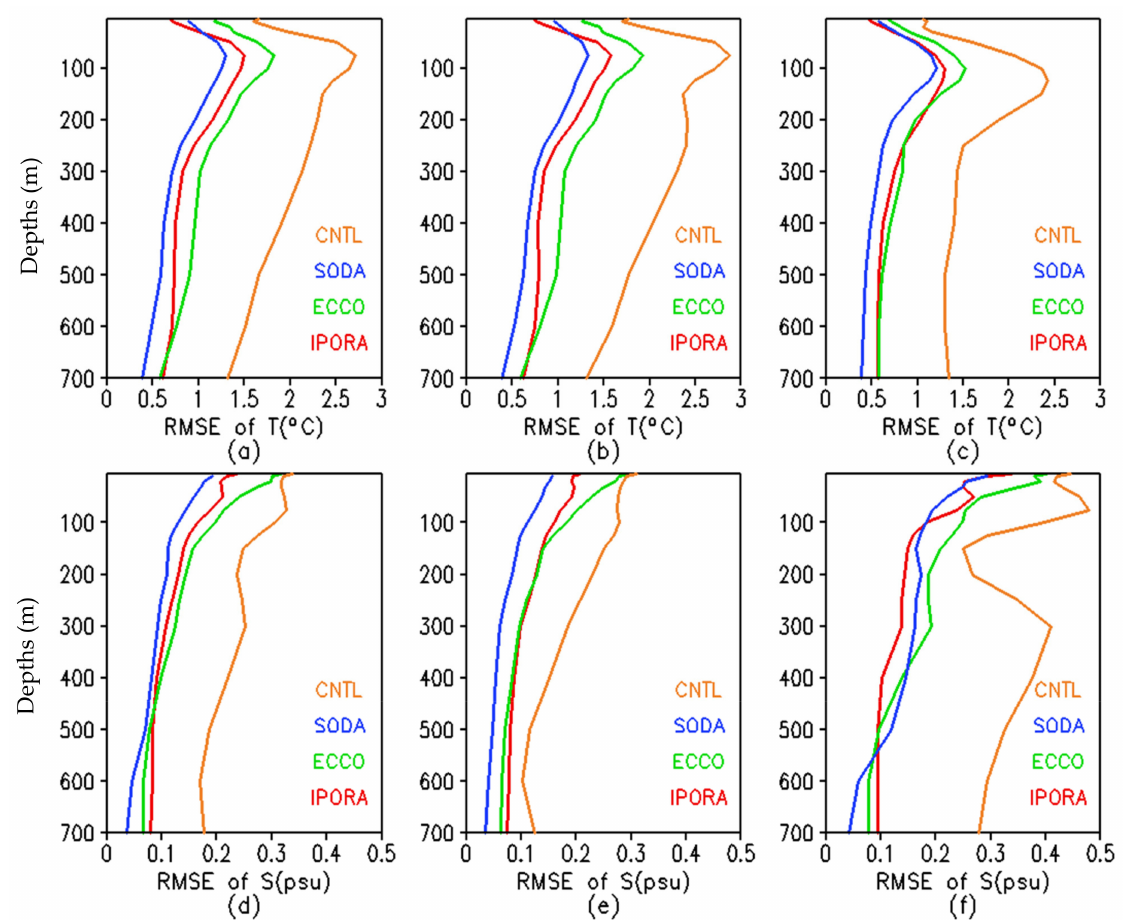
Figure 4. The vertical distribution of the RMSEs of temperature ( a – c ) and salinity ( d – f ) against the independent profiles over the period 2010–2011 from CNTL, IPORA, ECCO, and SODA in different regions. ( a , d ) the Indian and Pacific oceans, ( b , e ) the Pacific Ocean, and ( c , f ) the Indian